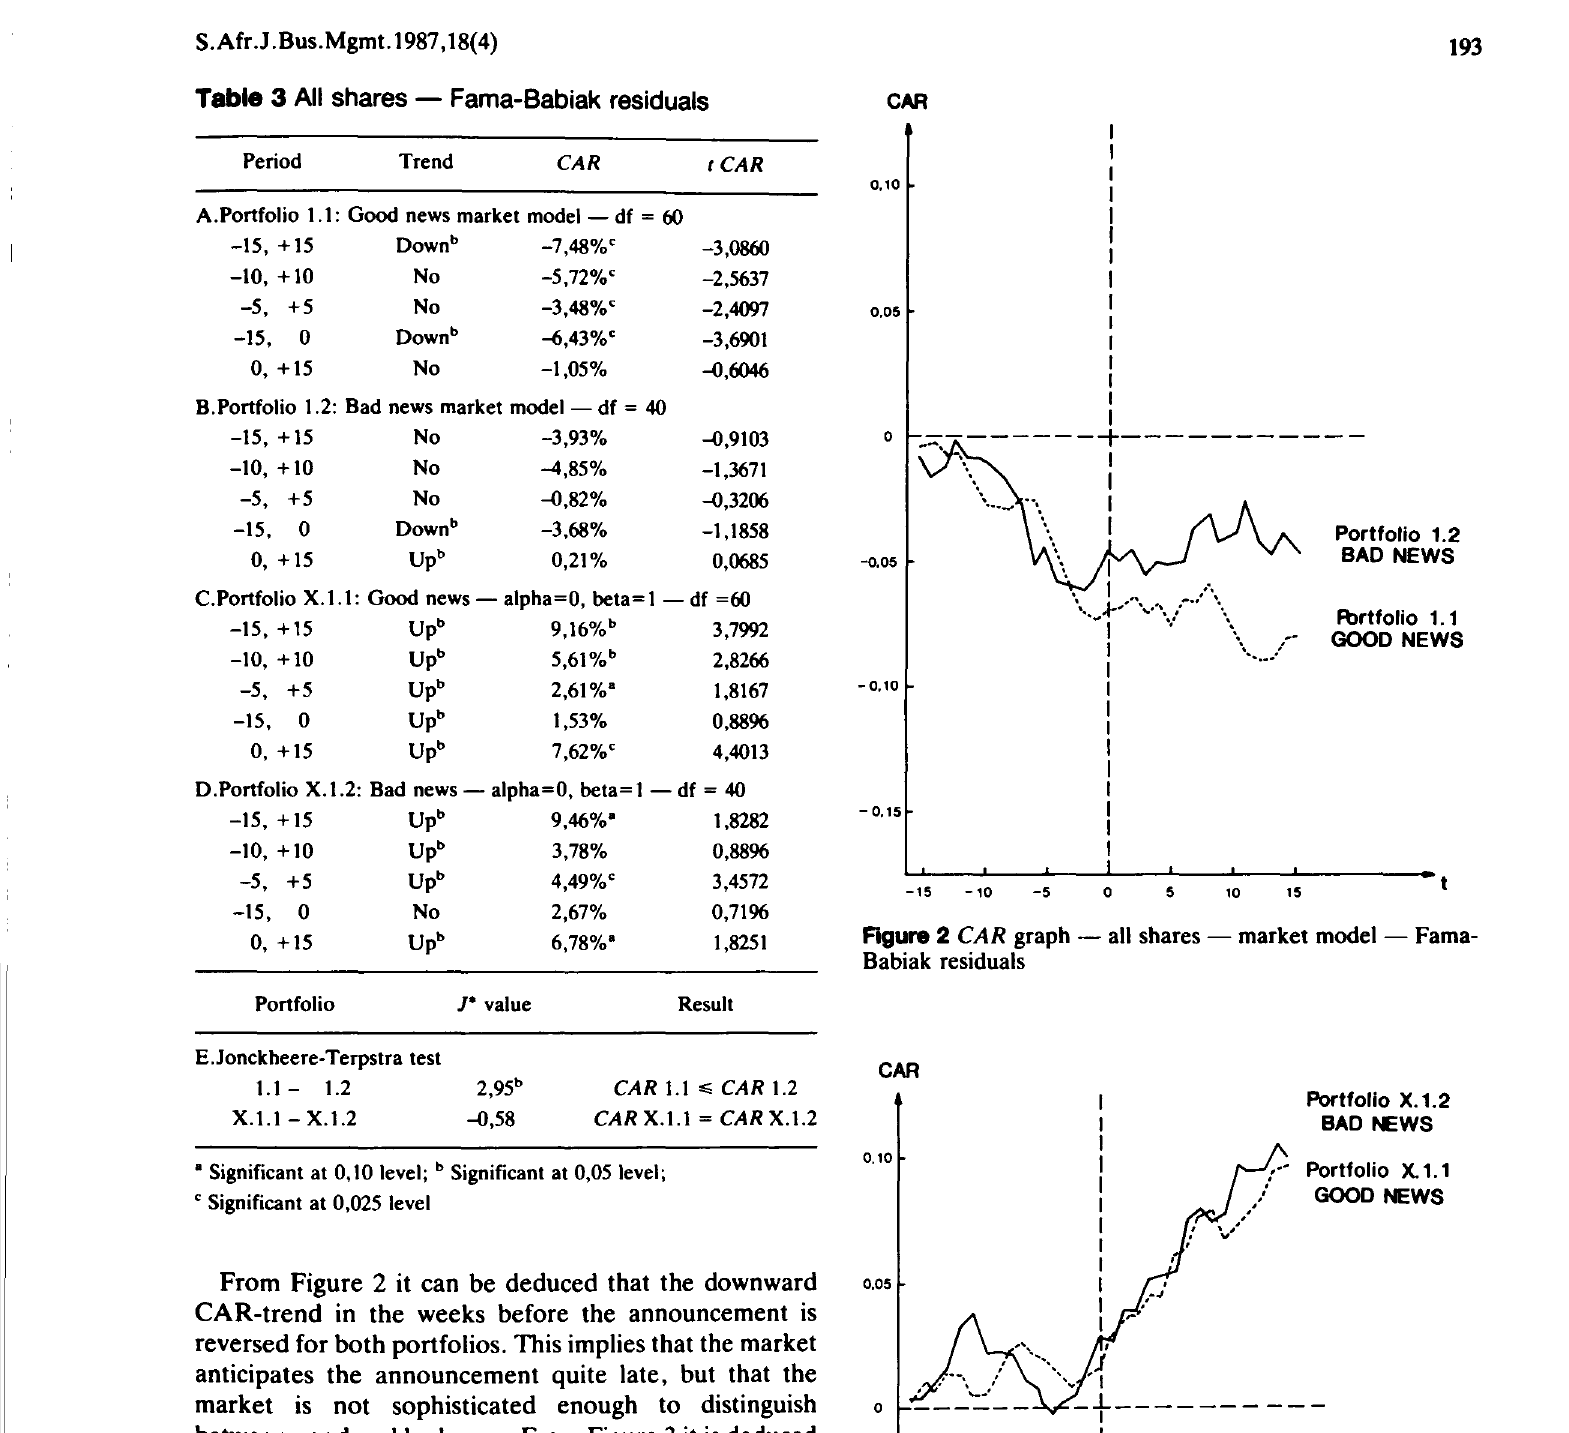
Figure 2 CAR graph - all shares - market model - Fama